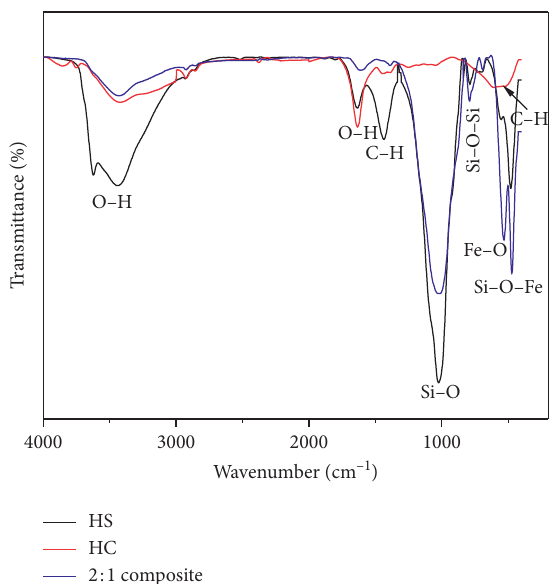
Figure 3: FT-IR spectrum of HS, HC-Fe, and 2:1 composite.